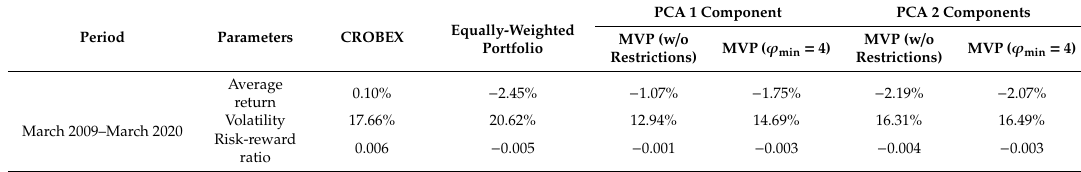
Table 3. Performance of the estimated MVP using original (untilted) returns as inputs for PCA. Period Parameters